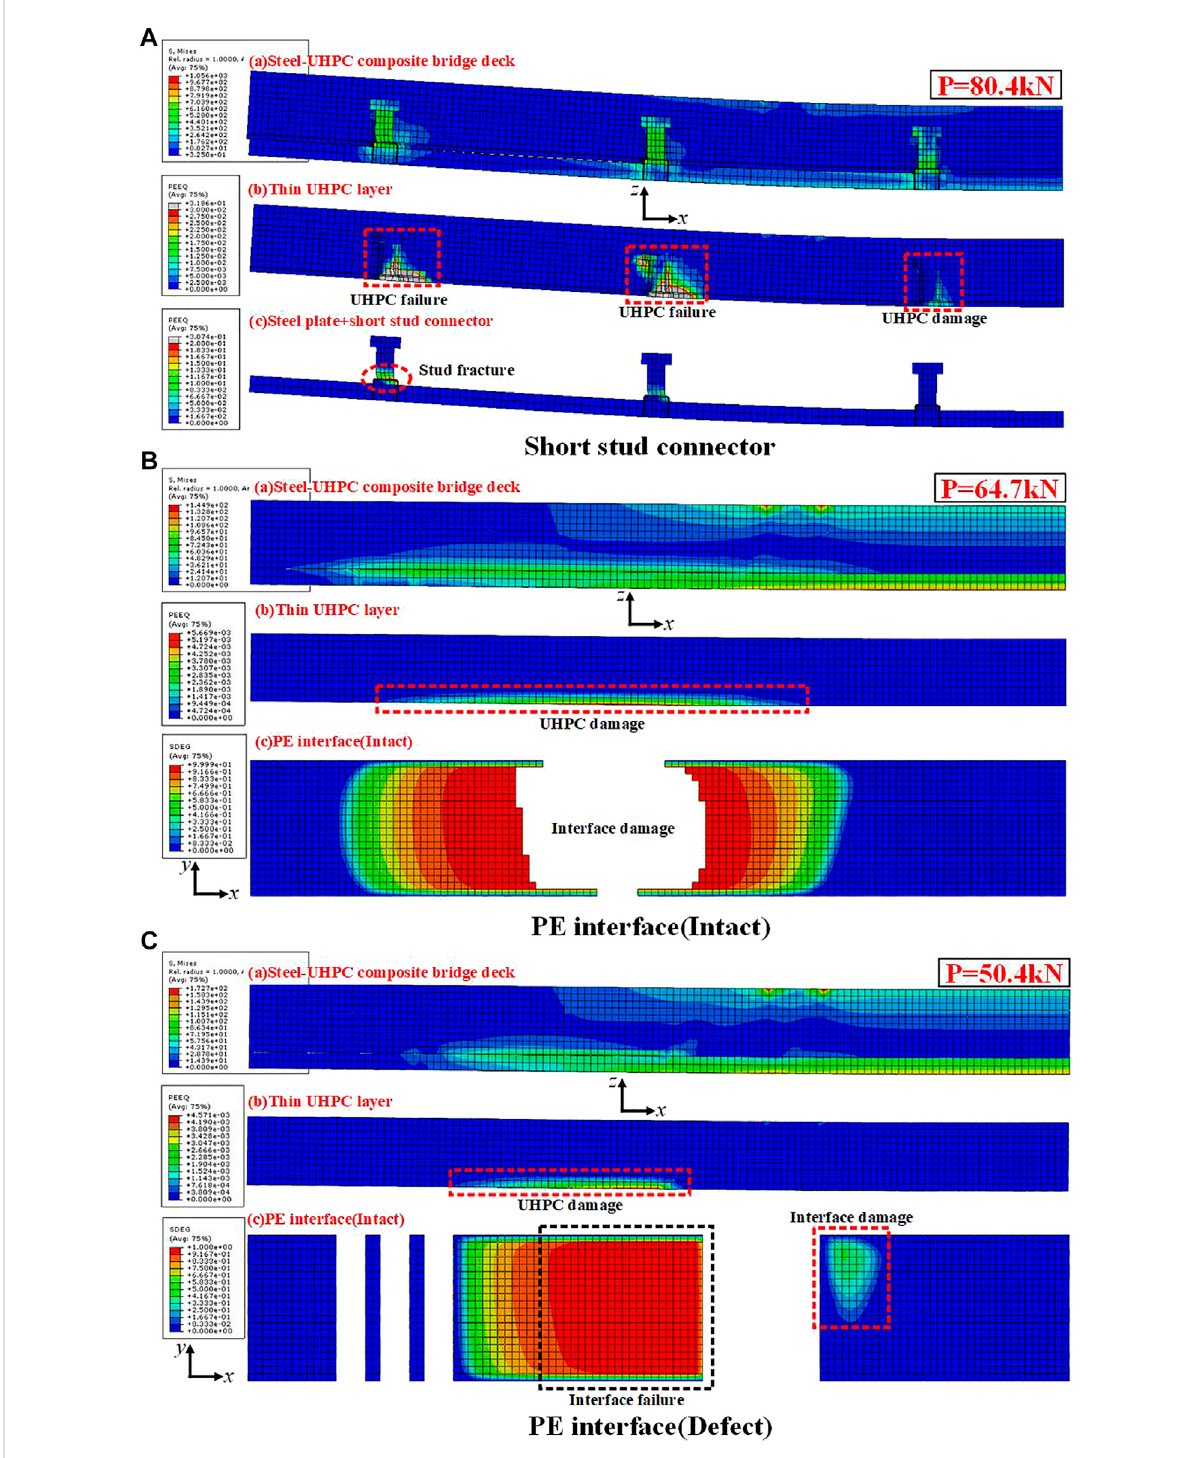
FIGURE 16 Damage of thin UHPC layer, short stud connector, and PE interface. (A) Short stud connector. (B) PE interface (Intact). (C) PE interface (Defact).